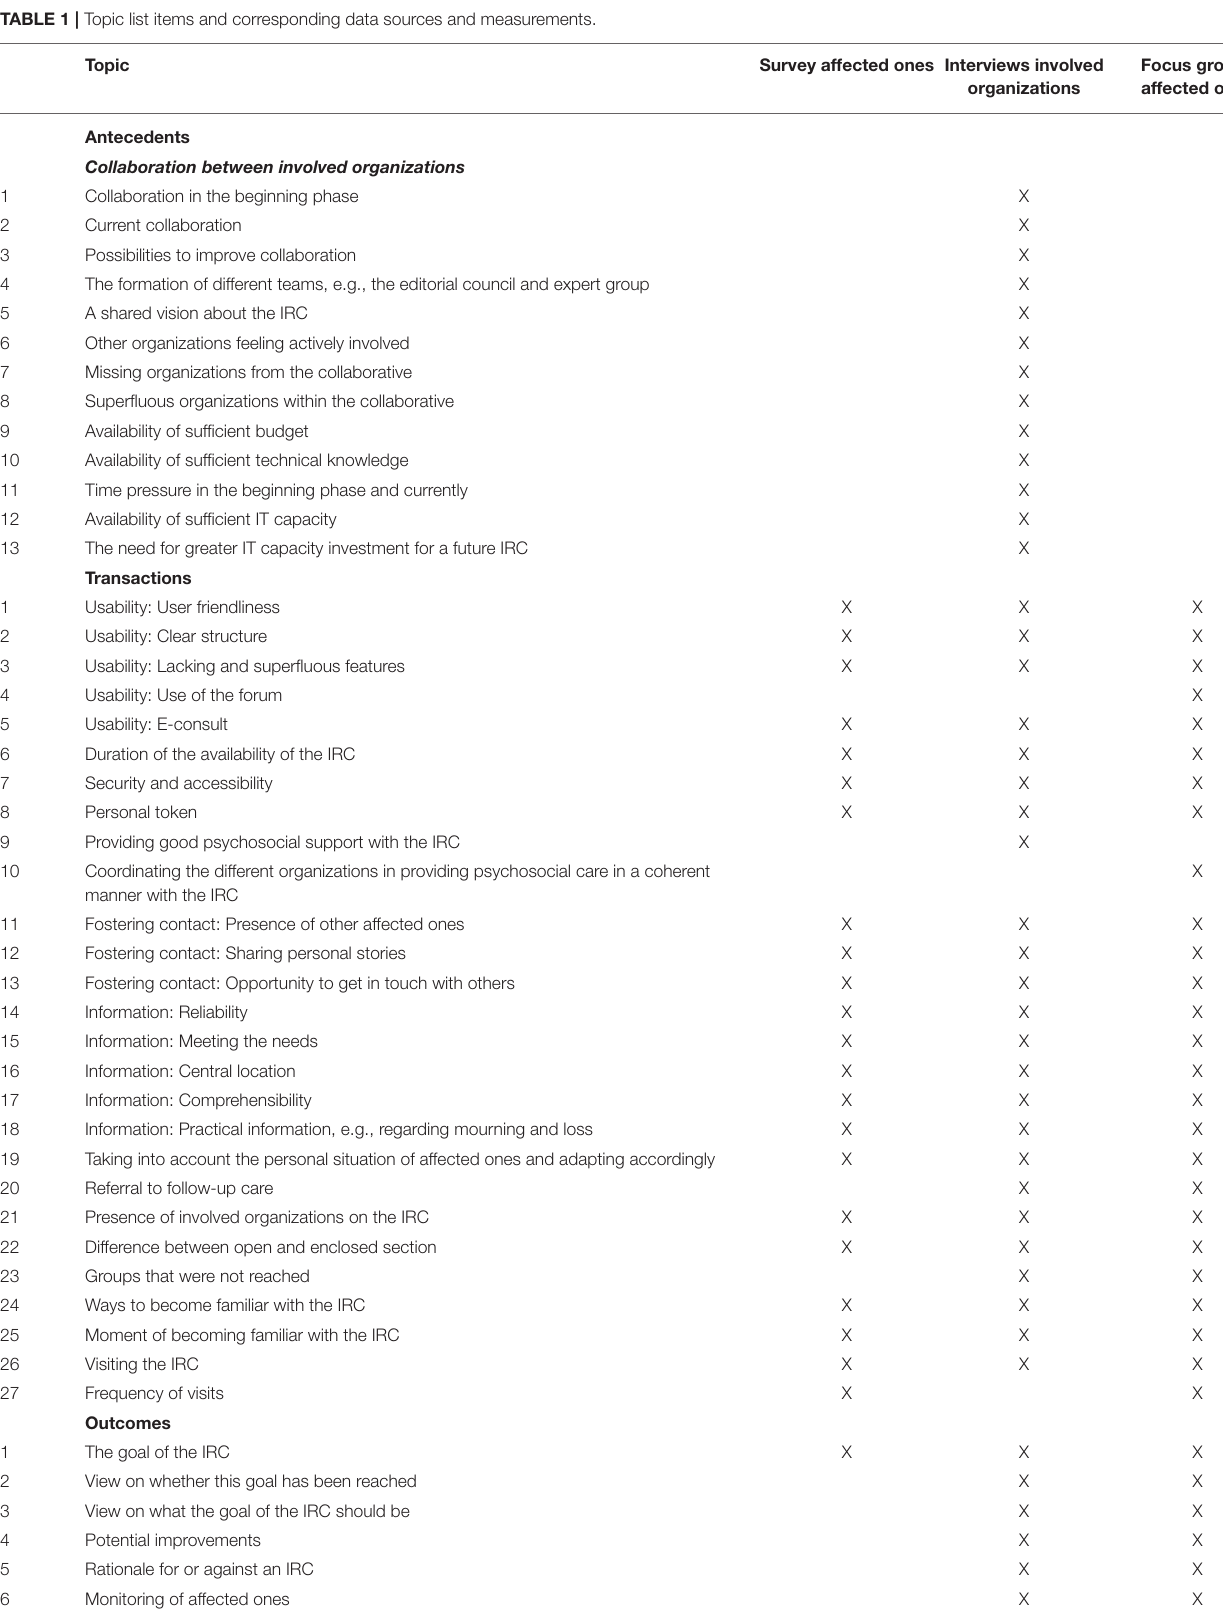
TABLE 1 | Topic list items and corresponding data sources and measurements. Topic Survey affected ones Interviews involved